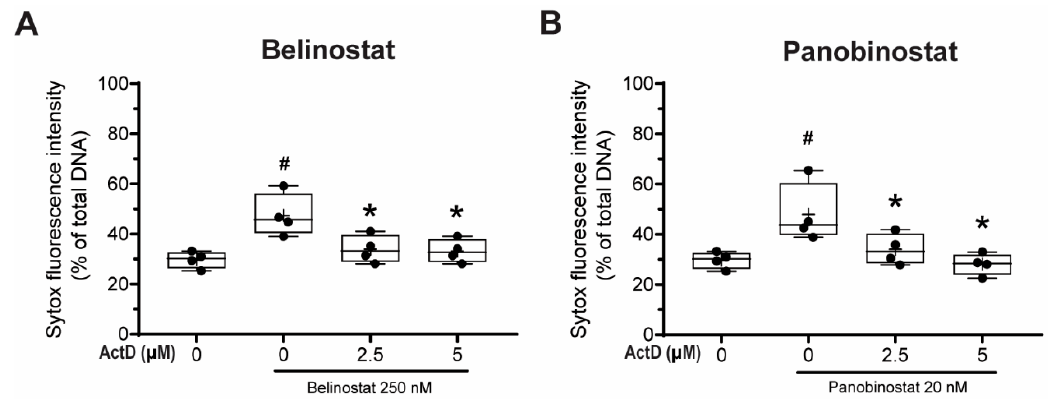
Figure 6. Transcription is required for HDACis to promote NETosis. Neutrophils were treated with 250 nM belinostat or 20 nM panobinostat in the presence of 0, 2.5 and 5 µ M actinomycin D (Act-D), a DNA transcription inhibitor. After 4-h treatment, Sytox Green fluorescence intensities were measured by using a fluorescence plate reader. ( A , B ) Neutrophils treated with Act-D had significantly lower total DNA release than belinostat- ( A ) or panobinostat-induced NETosis ( B ). The full data spread is indicated with lines, and boxes marked with the mean (+), median and upper and lower interquartile ranges. * p < 0.05 versus baseline with no HDACi; # p < 0.05 versus HDACi only (One-Way ANOVA with Tukey post-test conducted at each time points; n = 4). See Supplementary Figure S9 for additional information.